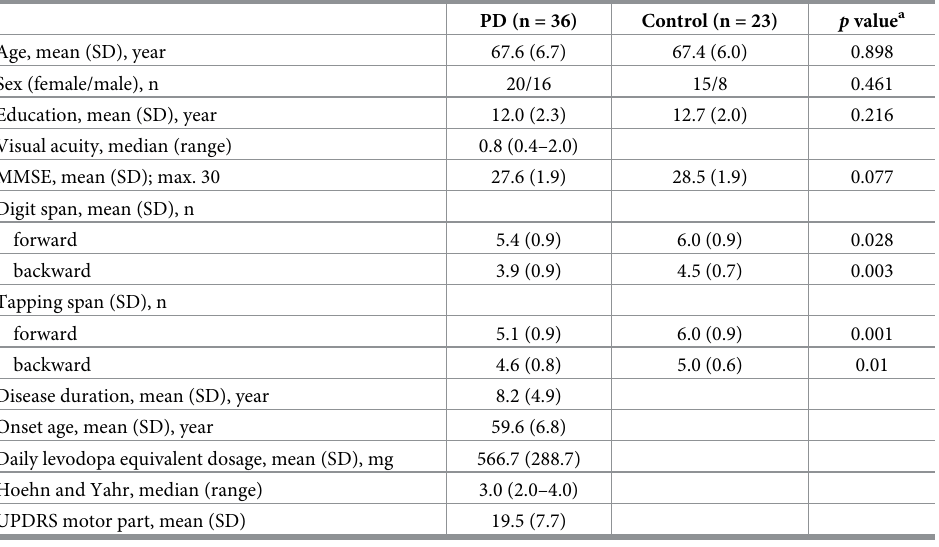
Table 1. Demographic and clinical characteristics of the PD patients and healthy